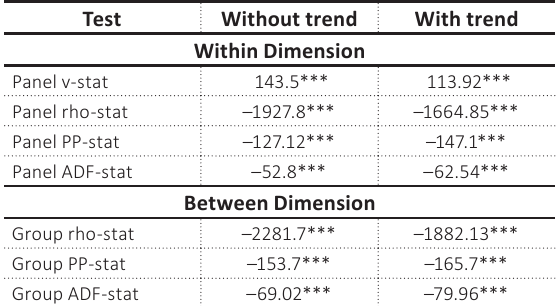
Table 2. Pedroni cointegration